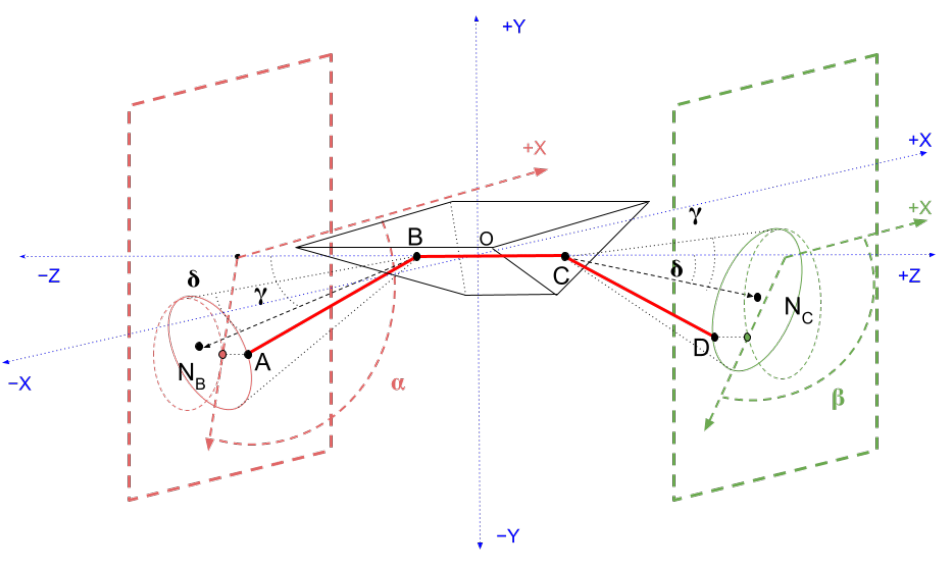
Figure 7. Twist Spectrum Proof